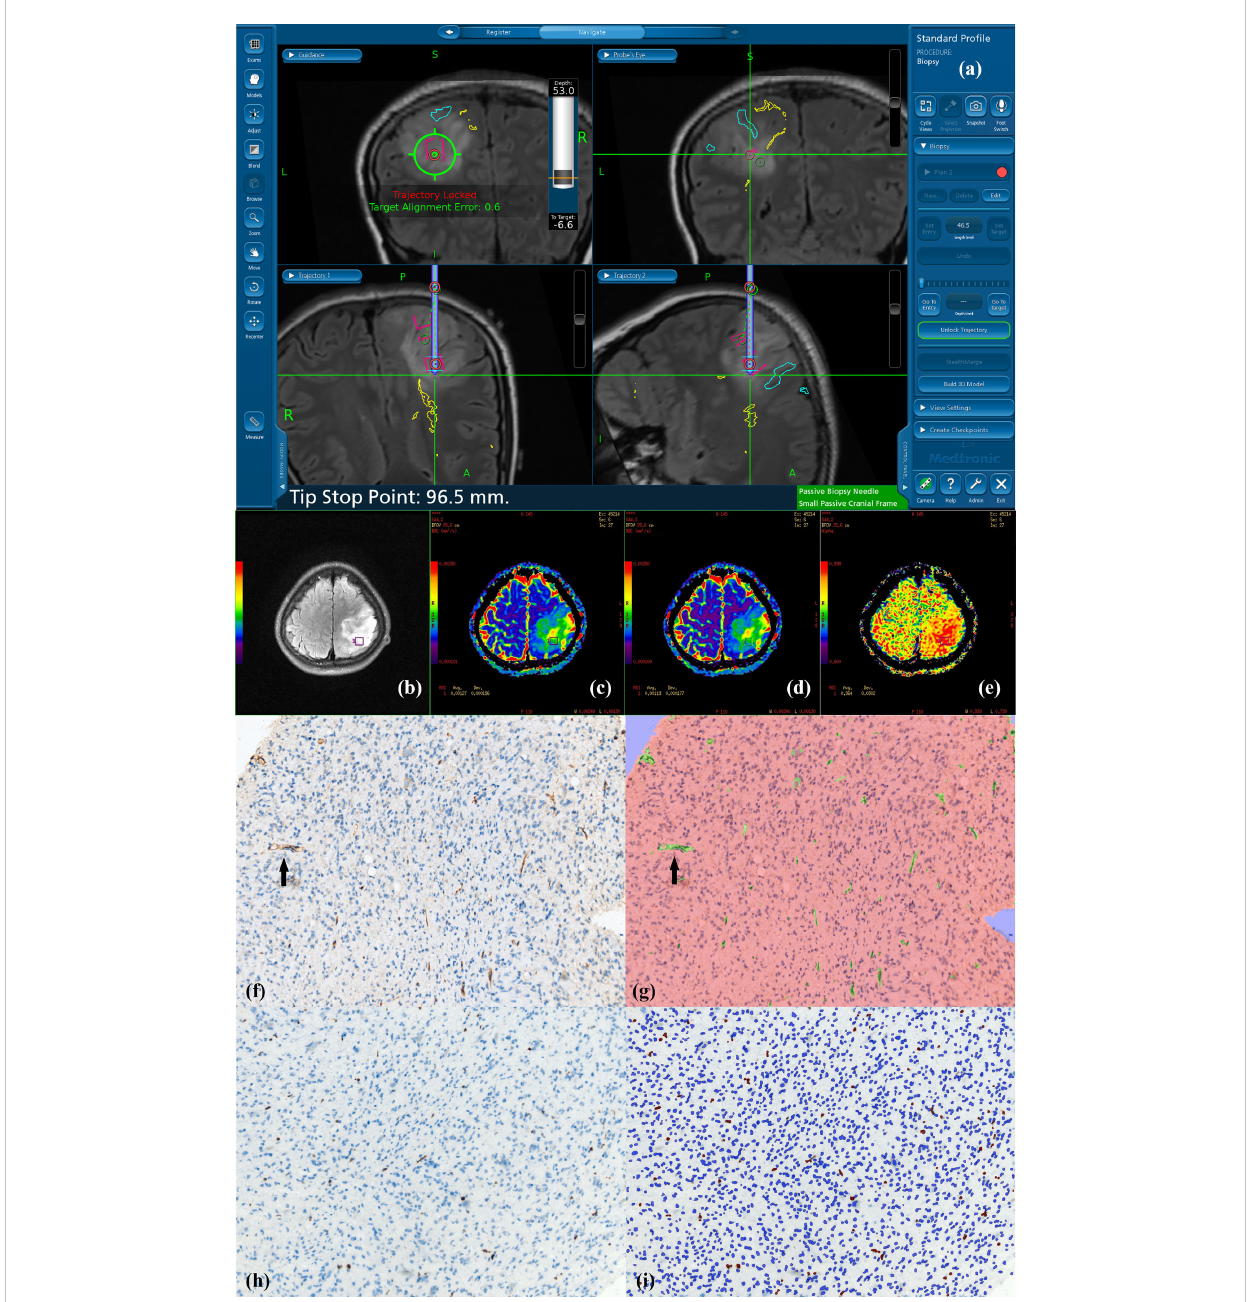
FIGURE 1 Navigated biopsy in a 31-year-old woman with pathologically con fi rmed WHO grade II astrocytoma. (A) Preoperative T2-FLAIR imaging was used for MR-guided biopsy; one specimen was obtained within the marked target regions (red circle) from the solid partition of tumor. (B) Target ROI taking the biopsy target coordinates as the center is shown on axial T2-FLAIR imaging (purple square in B). (C) DDC 1500 mapping with the biopsy target (ROI: green square) (D) DDC 5000 mapping with the biopsy target (ROI: green square) (E) a 1500 mapping with the biopsy targets (ROI: green square). (F) AntiCD34 immunohistochemical staining (original magni fi cation ×200 for all stains). (G) Computer assisted quanti fi cation is used to outline and calculate the neovascularization area in green. Black arrow shows microvasculature stained with CD34. (H) MIB-1 expression by using a high-power objective with a magni fi cation of 200×. Immunohistochemical dying of specimen from the biopsy target showed MIB-1 expression, proliferation indexes were 4.02%. (I) Computer assisted quanti fi cation is used to outline and calculate the MIB-1 expression area in